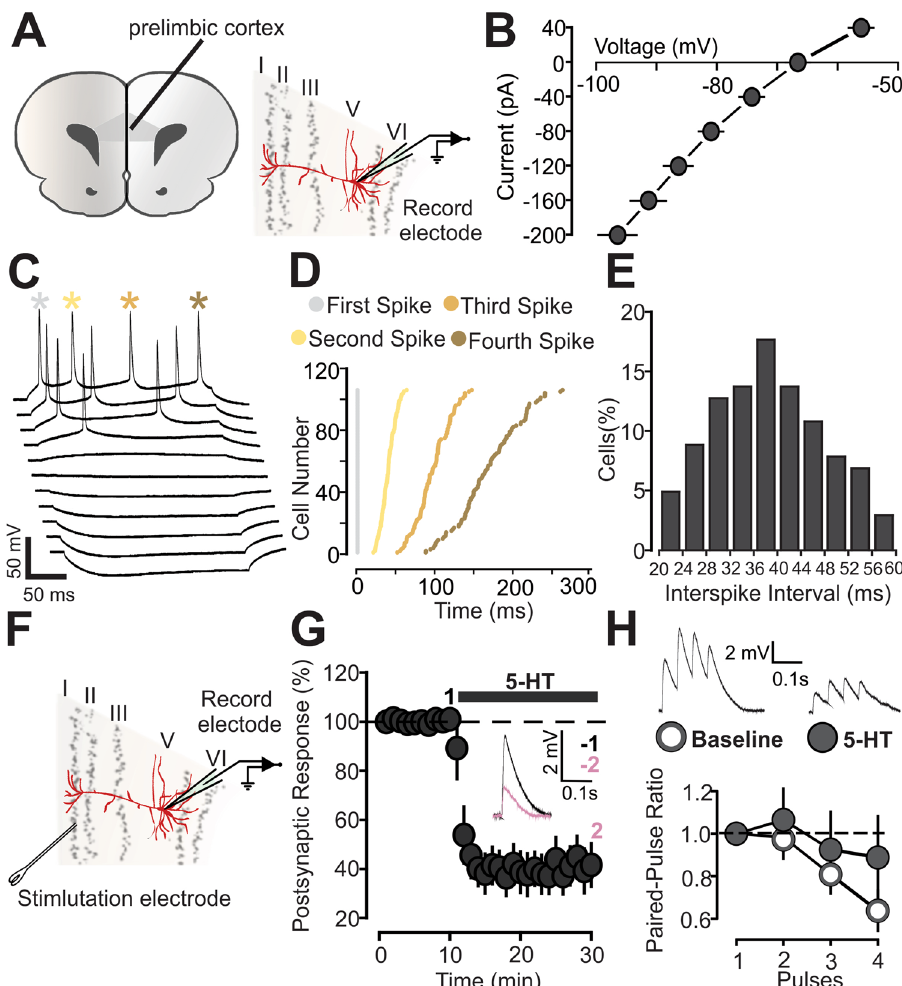
Figure 1. 5-HT reduces the amplitude of postsynaptic responses. ( A ) Scheme showing the prelimbic region of medial PFC on a coronal slice and the position of the stimulation electrode and recorded neurons. ( B ) Current–voltage (I–V) plots of PFC layer 5 neurons at P14-16. ( C ) Example of action potentials obtained by current injection in pyramidal neurons from layer 5. ( D ) The graph shows the cumulative relative spike intervals of neurons recorded from layer 5 at P14-16. The interval values were normalized with respect to the first spike time (t = 0). ( E ) The graph shows the frequency histogram for the interspike intervals of neurons recorded from layer 5 at P14-16. ( F ) Scheme showing the position of the stimulation electrode and recorded neurons in the prelimbic region of medial PFC. ( G ) The graph shows the EPSPs recorded in P14-16 animals before and during 5-HT (50 µM) bath application. The EPSPs were normalized to the mean of responses recorded during the baseline. The black bar represents the period of application of 5-HT in the bath. The EPSPs were normalized to the mean of responses recorded during the baseline and the bars represent the SEM. Traces show the results of a representative experiment the average of postsynaptic responses recorded before (1: 5 to 10 min, black line) and after (2: 25 to 30 min, magenta line) application of 5-HT. ( H ) Graph showing the paired pulse ratio of EPSPs in P14-16 animals. Two different conditions are compared: control (white inserts) and 5-HT application (gray inserts). Postsynaptic responses were normalized to the response caused by the first pulse. The EPSPs were normalized to the mean of responses recorded during the baseline and the bars are respect to the SEM. Traces show the results of a representative experiment with the average of postsynaptic responses recorded before the baseline and 20 min after the bath application of